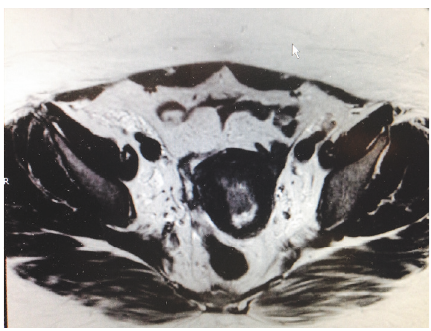
Figure 2: Magnetic resonance imaging of pelvic organs with Gadavist intravenous contrast demonstrated a 3.5 × 1.2 × 1.5 cm T2 enhancing mass with less than 50% invasion into the myometrium. No evidence of local regional metastatic